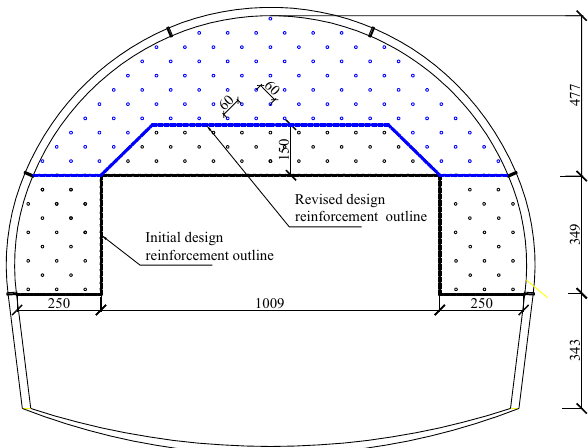
Figure 13. The reinforced face area before and after